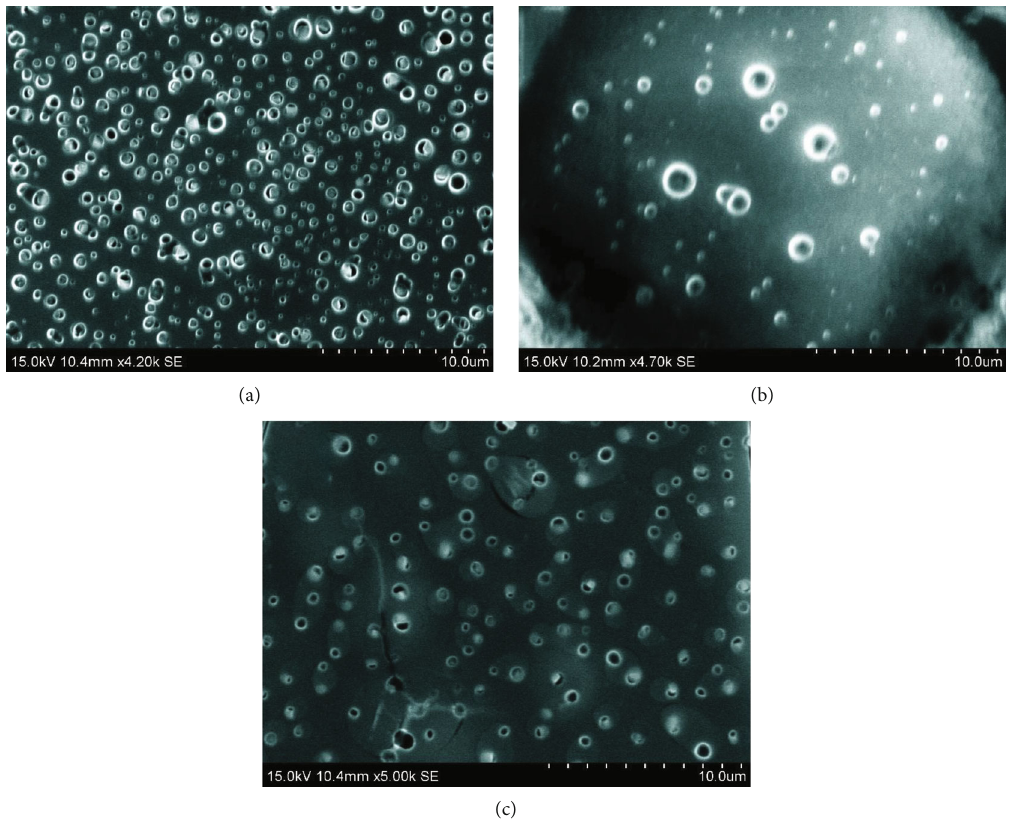
Figure 9: SEM images of bacterial cells (a) before and after treatment with (b) NF-k and (c)